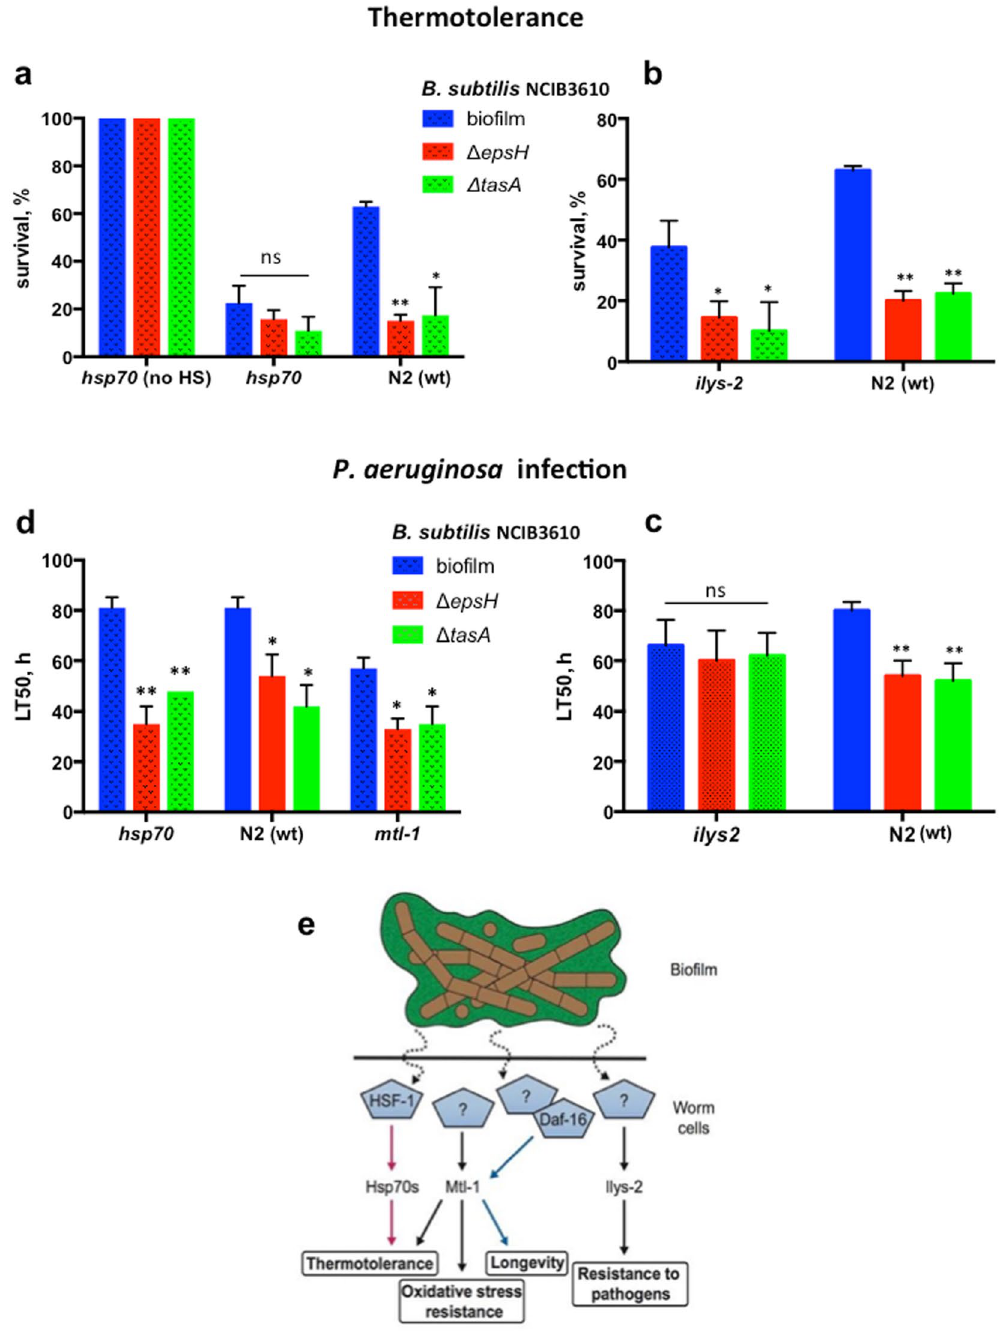
Figure 6. HSP70 and lysozyme contribute to biofilm-mediated resistance to heat and infection. ( a ) C. elegans hsp-70 ( F44E5.4 and F44E5.5 ) are required for biofilm-induced thermotolerance. Wild-type (N2) and hsp70 - deficient C. elegans were grown in parallel on biofilm-forming (biofilm) and biofilm-deficient ( Δ epsH , Δ tasA ) B. subtilis . Five-day old worms were subjected to heat shock as in Fig. 1a. Mean values ± SD from three independent biological replicates are plotted. Each biological replicate includes at least 60 worms per condition. One-way ANOVA p -value = 0.1210. ( b ) ILYS-2 is dispensable for the biofilm-mediated increase in C. elegans thermotolerance. N2 and ilys-2 worms were grown in parallel on indicated bacterial strains until day 5 of adulthood and then subjected to heat shock at 33 °C for 3 hours. Surviving animals were scored after 20 hours of recovery at 20 °C. ( c ) Biofilm-dependent induction of ilys-2 is essential for resistance to P. aeruginosa infection. Five-day old wild-type (N2) and ilys2 worms grown in parallel on indicated B. subtilis strains were transferred to P. aeruginosa PA14 seeded plates and survival was scored every 6 hours. LT50 was taken from Kaplan- Meier survival curves (median survival data). For the log-rank test p -values see Supplementary Table S2. ( d ) MTL-1 and HSP70 are not required for biofilm-dependent resistance to P. aeruginosa infection. Five-day old wild-type (N2), mtl-1 (tm1770) and hsp70 knockout worms grown in parallel on indicated B. subtilis